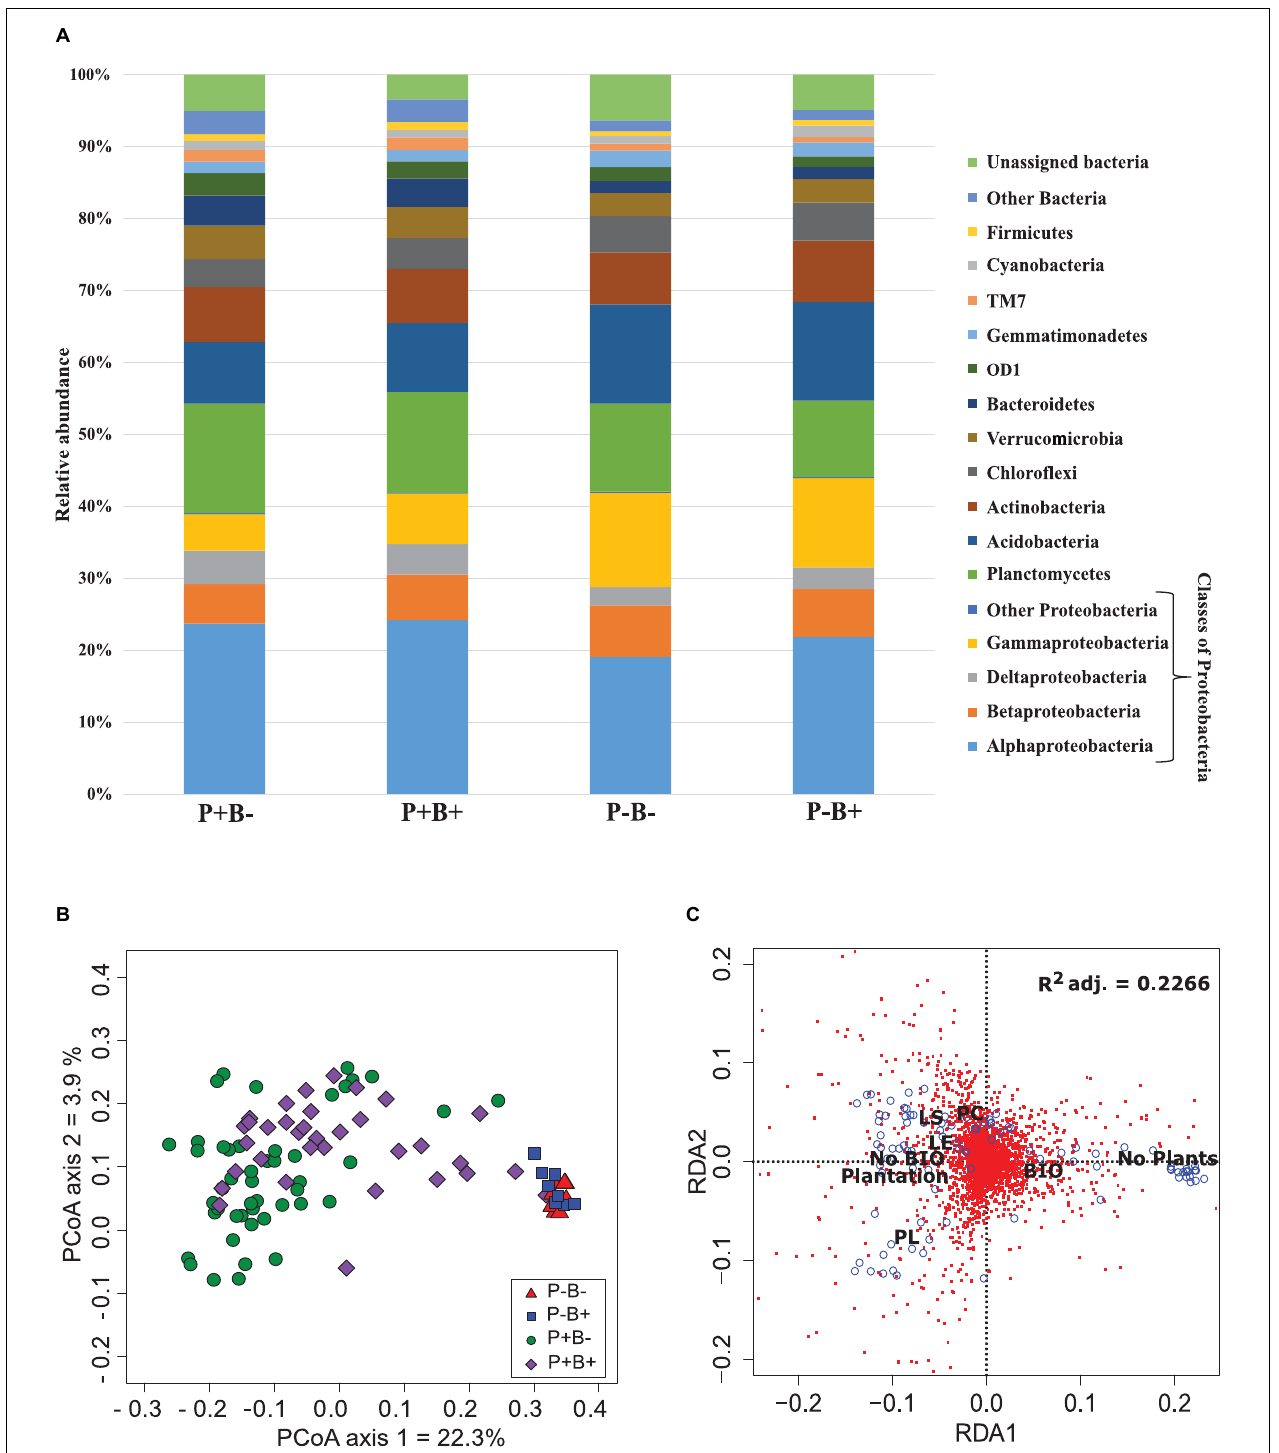
FIGURE 1 | (A) Effect of the plantation and bioaugmentation on the relative abundance of bacterial phyla or classes. (B) Principal coordinate analysis based on the Bray–Curtis dissimilarity of bacterial communities showing the effect of plantation and bioaugmentation. (C) Redundancy analysis (RDA) showing the relation between the abundance of bacterial OTUs and the factors Bioaugmentation, Plantation, and Plant species identity. The adjusted R 2 value indicates the amount of variance in bacterial community composition accounted for by the constraining factors (Bioaugmentation, Plantation, and Plant species identity). The location of labels represent factor centroids. Red squares indicate bacterial OTUs. Blue open circles represent individual samples. (Bio, Bioaugmentation; LE, Lycopus europaeus ; LS, Lythrum salicaria ; PC, Panicum capillare ; PL, Persicaria lapathifolia ).